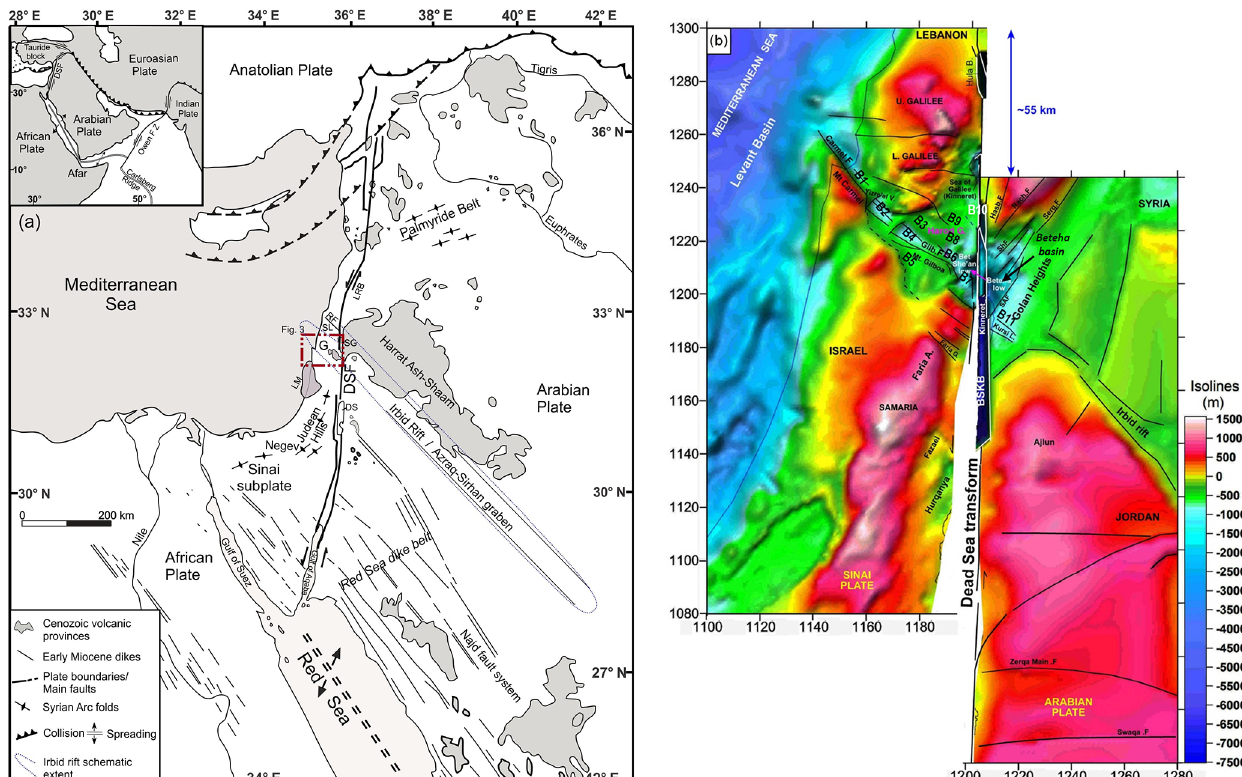
Figure 1. (a) Major tectonic, magmatic, and sedimentary elements along the eastern Mediterranean basin and surrounding plates (after Garfunkel, 1989; Ilani et al., 2001; Schattner et al., 2006a, b; Segev et al., 2014, 2017). Schematic extent of the Irbid rift is outlined in dashed blue lines. Inset – main tectonic elements in the vicinity of the Arabian Plate – the Dead Sea fault (DSF), Afar dome, and the Owen fracture zone (FZ). The Cretaceous Syrian Arc fold belt extends from Egypt to Syria across the Galilee. LM – Levant margin; G – Galilee; RF – Roum fault; SL – southern Lebanon; SG – Sea of Galilee (Fig. 3 for zoom-in); DS – Dead Sea; LRB – Lebanese restraining bend. Bordeaux outline – study area, presented in Fig. 3. (b) Reconstructing the pre-DSF plate configuration using the structural map of the top Judea Group interface (modified from Segev et al., 2014). The Beteha basin on the Arabian Plate is attached to the Bet She’an basin on the Sinai subplate, which showed a ∼ 55km motion along the DST. Basins referred to herein are marked by the B series (B1 to B11). Abbreviations: F., fault; V., valley; B., basin; L., low; Mt., Mount; Hasb., Hasbaya; Rach., Rachaya; Serg., Serghaya; SAF, Sheikh Ali fault; BSKB, Bet She’an Kinarot basin; DST, Dead Sea